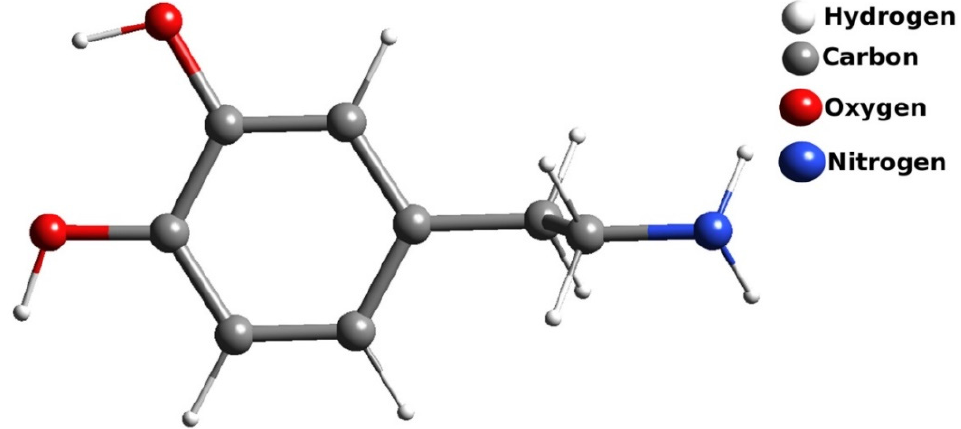
Figure 2. Graphical representation of fabricating green synthesized CuO nanoparticle modified carbon paste electrode.